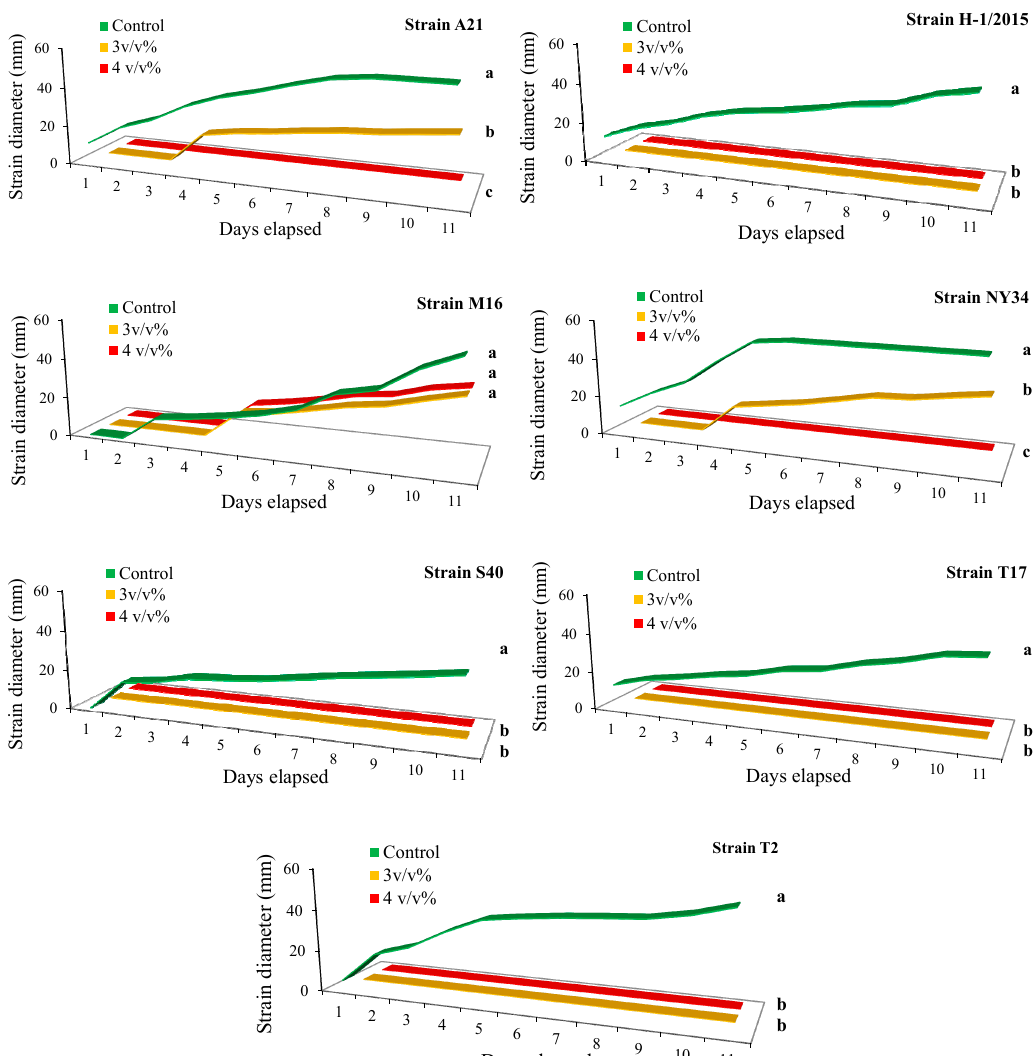
Figure 1. Growth (mm) of di ff erent late blight strains treated with 3 and 4 v / v % populin and distilled water (control) during the 10-day assessment period. Di ff erent letters mean statistically significant di ff erences at the p ≤ 0.01 level (Mann-Whitney test). Higher infection intensity at the 1% level was observed after 24 h using Valis M (Figure 3D). The same tendency toward 10% infection remained after 48 and 72 h using Valis M with similar high infection intensity for the control as well (Figure 3E,F). PCA also revealed the e ff ectiveness of populin 5% and 10% under field conditions. According to PCA, synthetic fungicide Valis M allowed an average of 10% infection after 24, 48 and 72 h, while the lack of any treatments resulted in 25% infection in all time points (Figure